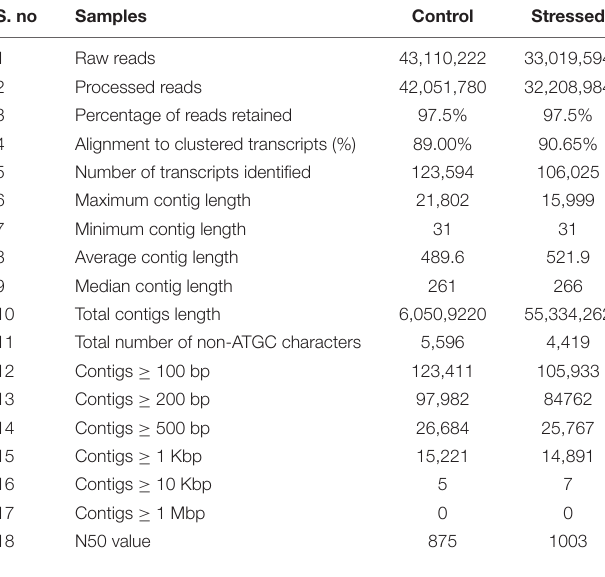
TABLE 1 | Sample wise assembly statistics of cluster bean cultivar RGC-1025